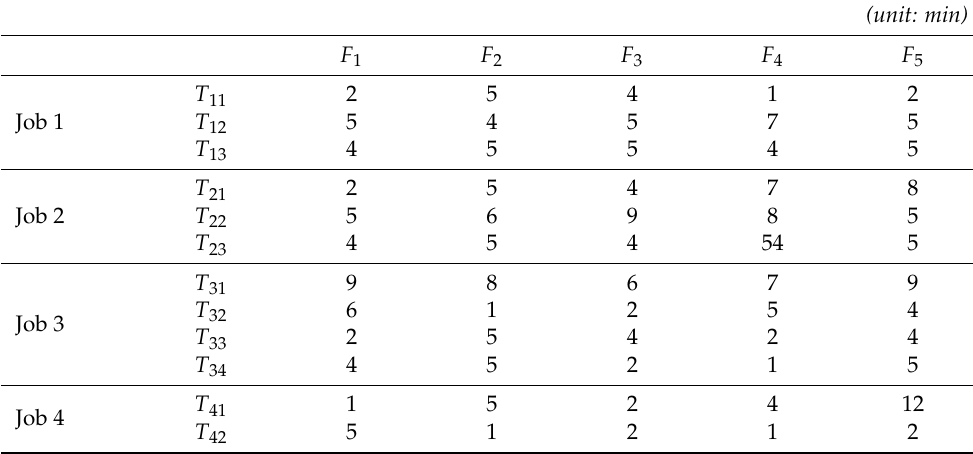
Figure 18. Step 3 of the hybrid-type negotiation process. Table 4. Experiment result of GA for negotiation